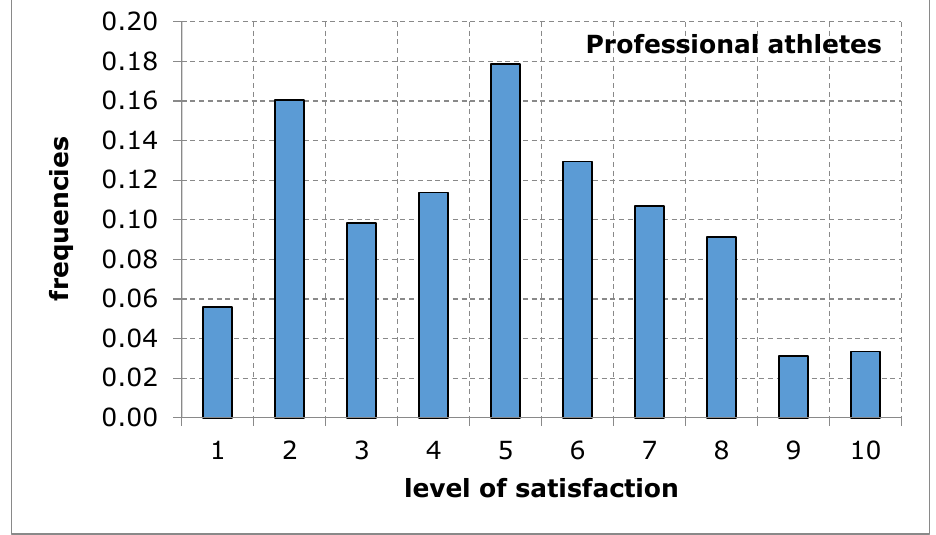
Figure 2. A sports and recreation facility is not publicly available to residents of the city of Poznan, in the opinion of service recipients (professional athletes). Source: own work. Table 5. Statistical characteristics of the availability of sports and recreation facilities for the residents of the city of Poznan, in the opinion of service recipients.